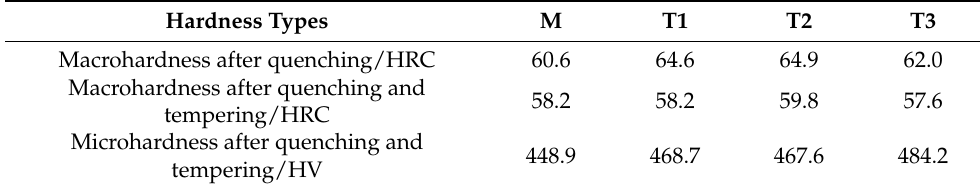
Table 7. Hardness of the studied alloys.